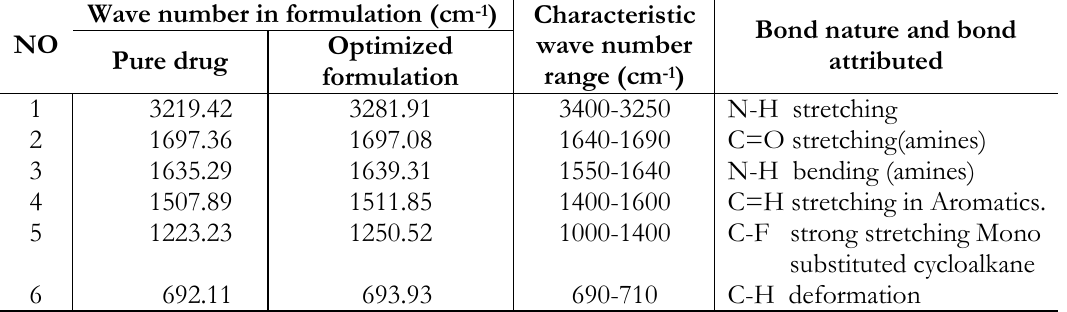
Table IV. Drug-excipient interactive studies.